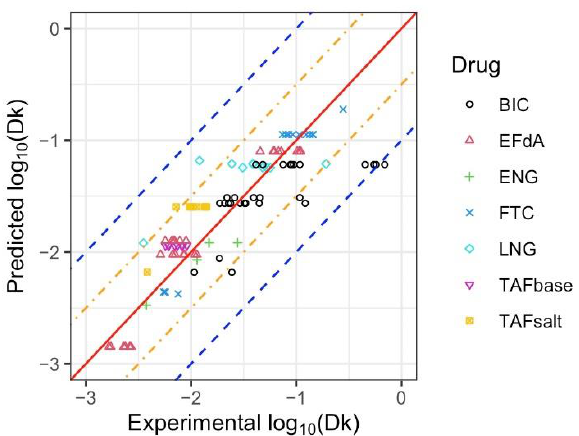
Figure 2. Predicted and experimental values of log 10 (𝐷𝑘) for BIC, EFdA, ENG, FTC, LNG, TAF base , and TAF salt . The solid red diagonal line indicates when the prediction and observation are the same, the orange and blue dashed lines indicate predictive values within 0.5 log and 1 log of the observed values, respectively. Different symbols represent each drug, with multiple points for the same symbol representing different configurations of drug formulation or implant design tested for each drug.